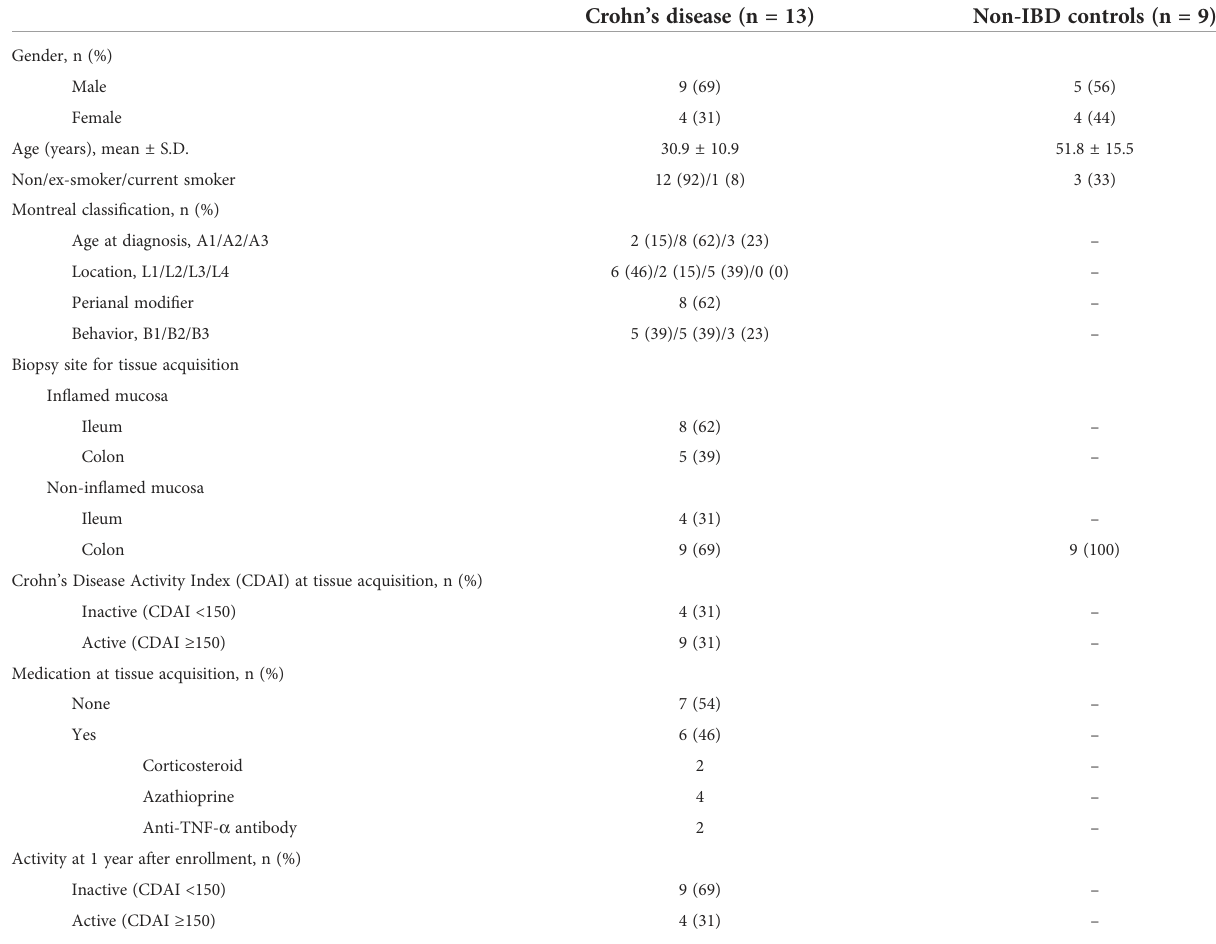
TABLE 1 Characteristics of enrolled patients with Crohn ’ s disease and non-IBD